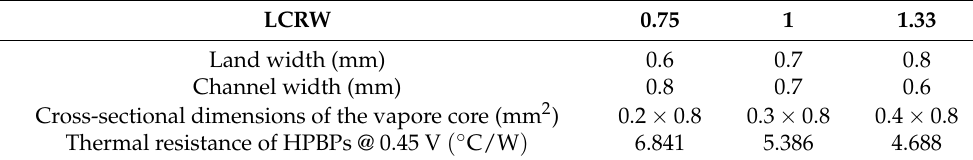
Table 6. Structural parameters and total thermal resistance of heat pipes for different LCWRs. LCRW